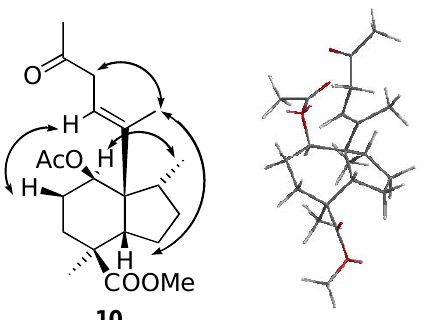
Figure 6. nOe experiments for determination of the configuration of 10 and a Chem 3D model to better understand the